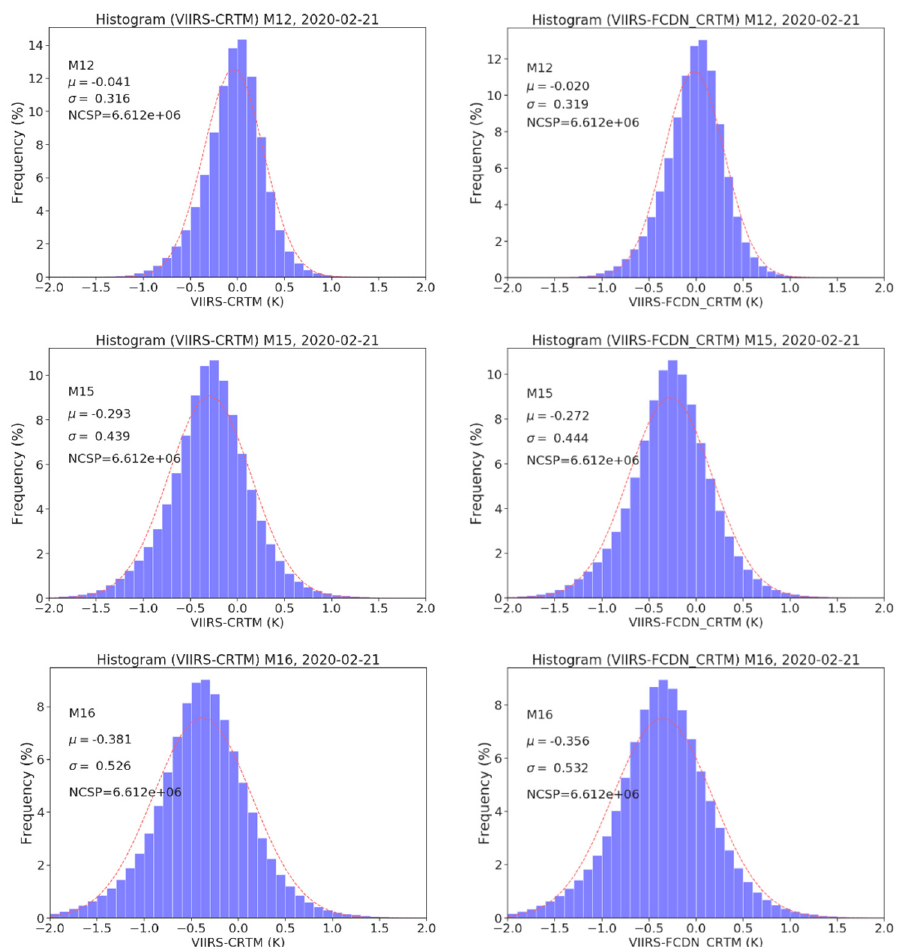
Figure 7. Global histograms of the V-C ( left panels ) and V-F ( right panels ) for M12 ( upper ), M15 ( middle ) and M16 ( bottom ) on February 21, 2020. Table 4. Global mean and STD for SNPP VIIRS on 21 February 2020 between V-C and V-F (V-C: difference between VIIRS BT and CRTM BT; V-F: difference between VIIRS BT and FCDN_CRTM BT; µ: V-C or V-F mean bias; σ : standard deviation).